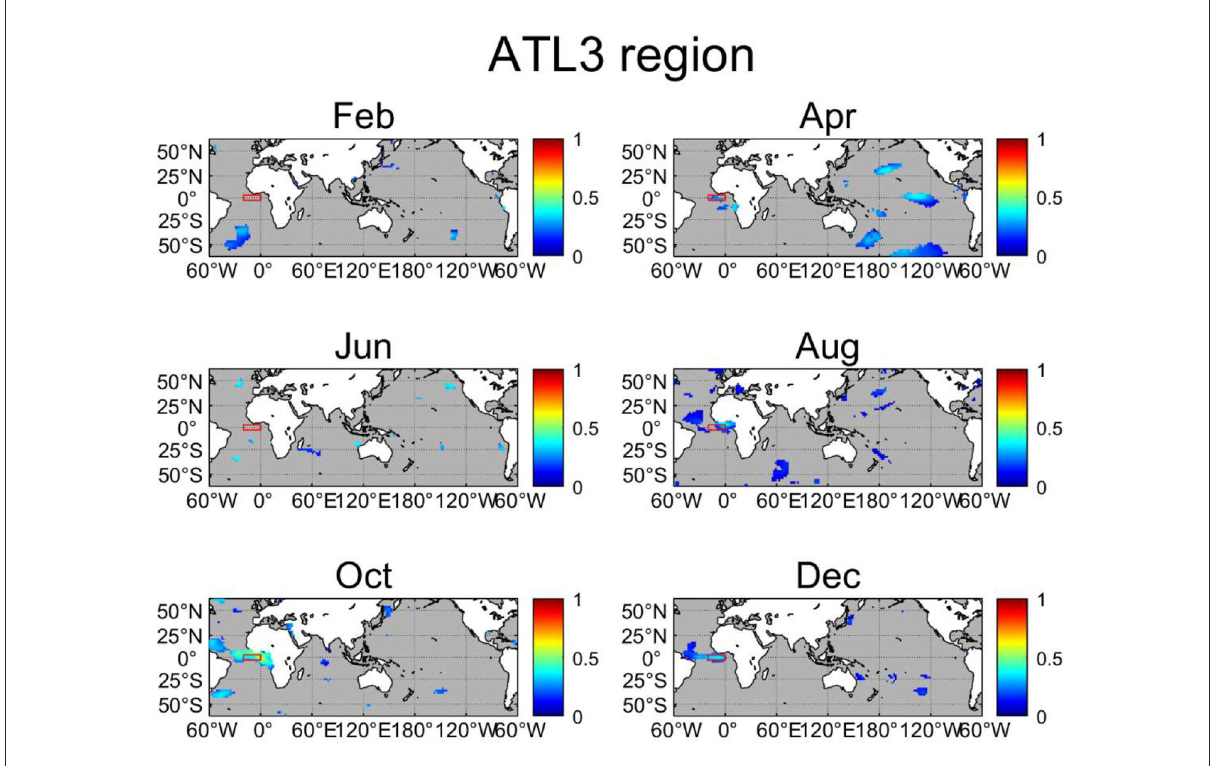
FIGURE12 As in Figure 8, but for the ATL3 region (20 ◦ W